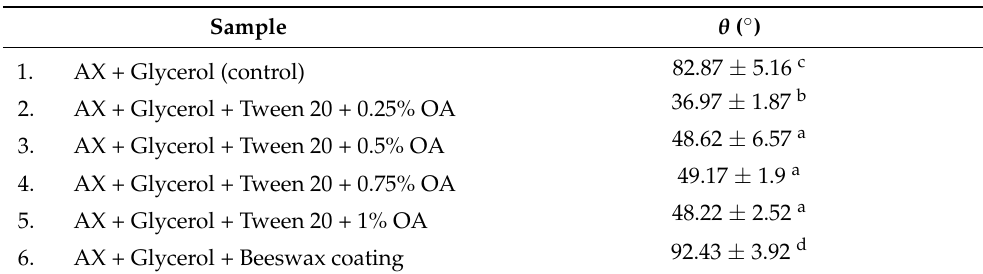
Table 9. Static water contact angle ( θ , ◦ ) values of all the film samples. Values in the same column followed by different superscript letters differ significantly ( p <